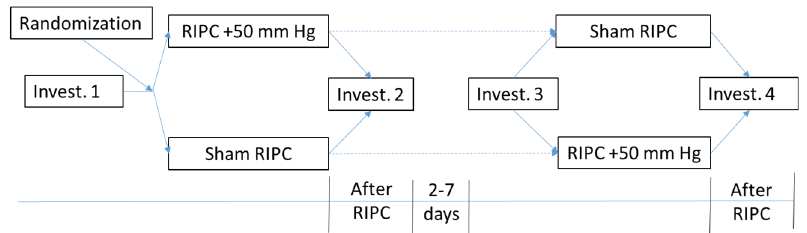
Figure 1. Protocol of the study both in control ( n = 20) and CHD ( n = 30) groups. SBP—systolic blood pressure; RIPC—ischemic preconditioning; sRIPC—sham ischemic preconditioning. The dotted arrows shows the crossover order of investigation in the groups.